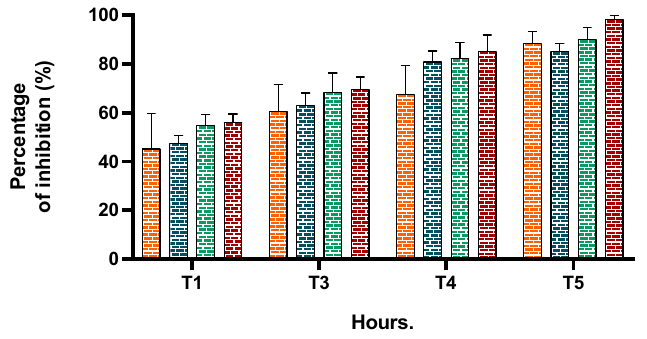
Figure 4: Percentage of edema inhibition. The values are expressed as mean ± SD ( n = 5 )